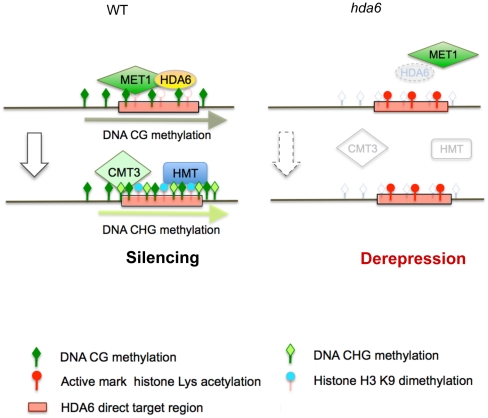
Mechanistic model for epigenetic heterochromatin silencing regulated by
HDA6.In our hypothetical model, HDA6 and MET1 cooperate in the initial step of
epigenetic silencing. HDA6 directs deacetylation of all lysine residues in
H3 and H4 N-tails, except H4K16. The CG DNA methyltransferase MET1 probably
requires HDA6 for its recruitment to the HDA6 target loci isolated from
other MET1 target loci. Once MET1 is recruited it directs CG DNA
methylation. After deacetylation by HDA6 and CG methylation by MET1, H3K9me2
is established by Histone Methyl Transferase(s) (HMT), followed by
H3K9me2-dependent CHG methylation by CMT3. In hda6, all
repressive modifications such as H3K9me2, histone deacetylation, and all DNA
methylation in all sequence contexts are lost. This results in
transcriptional derepression, indicating that HDA6 may trigger a series of
epigenetic modifications at heterochromatin, possibly as a recruiter, or as
a component of the silencing machinery in conjunction with MET1.